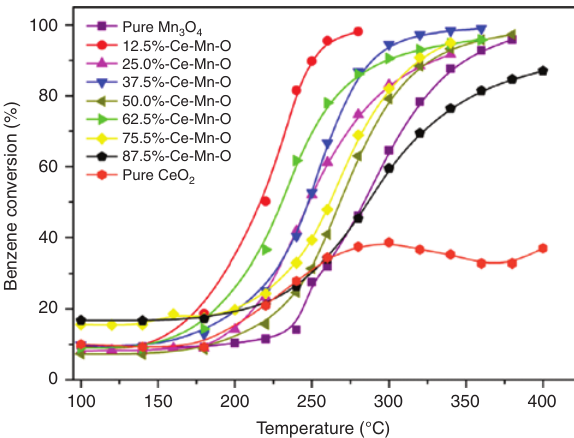
Figure 27: Benzene conversion as a function of temperature over flame-made CeO -MnO oxides with different Ce-to-Mn ratios: 2 x benzene = 1000 ppm, synthetic air (20 vol.% O balance, GHSV = 60,000 mLg cat-1 ·h -1 . Reproduced from [122] with permission from Elsevier